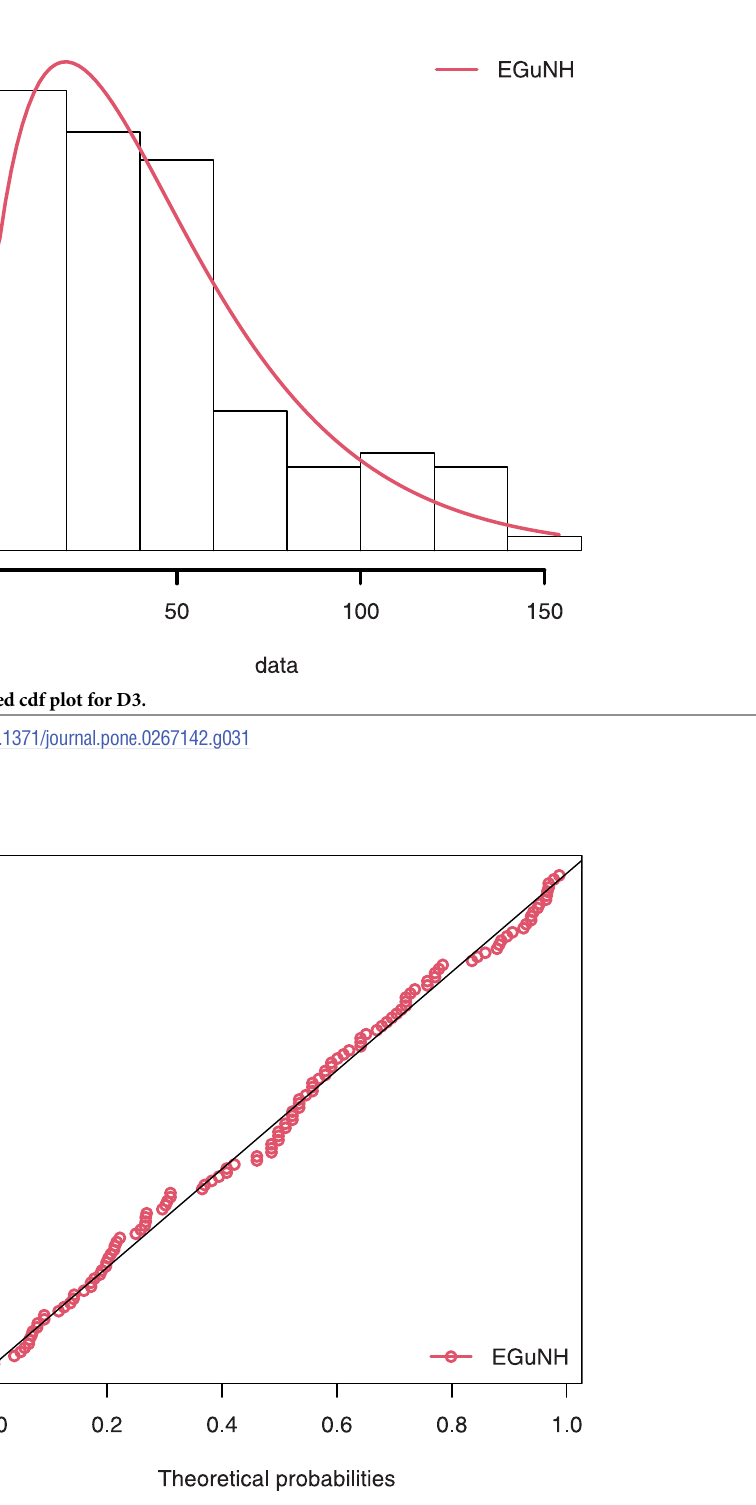
Fig 32. Estimated sf plot for